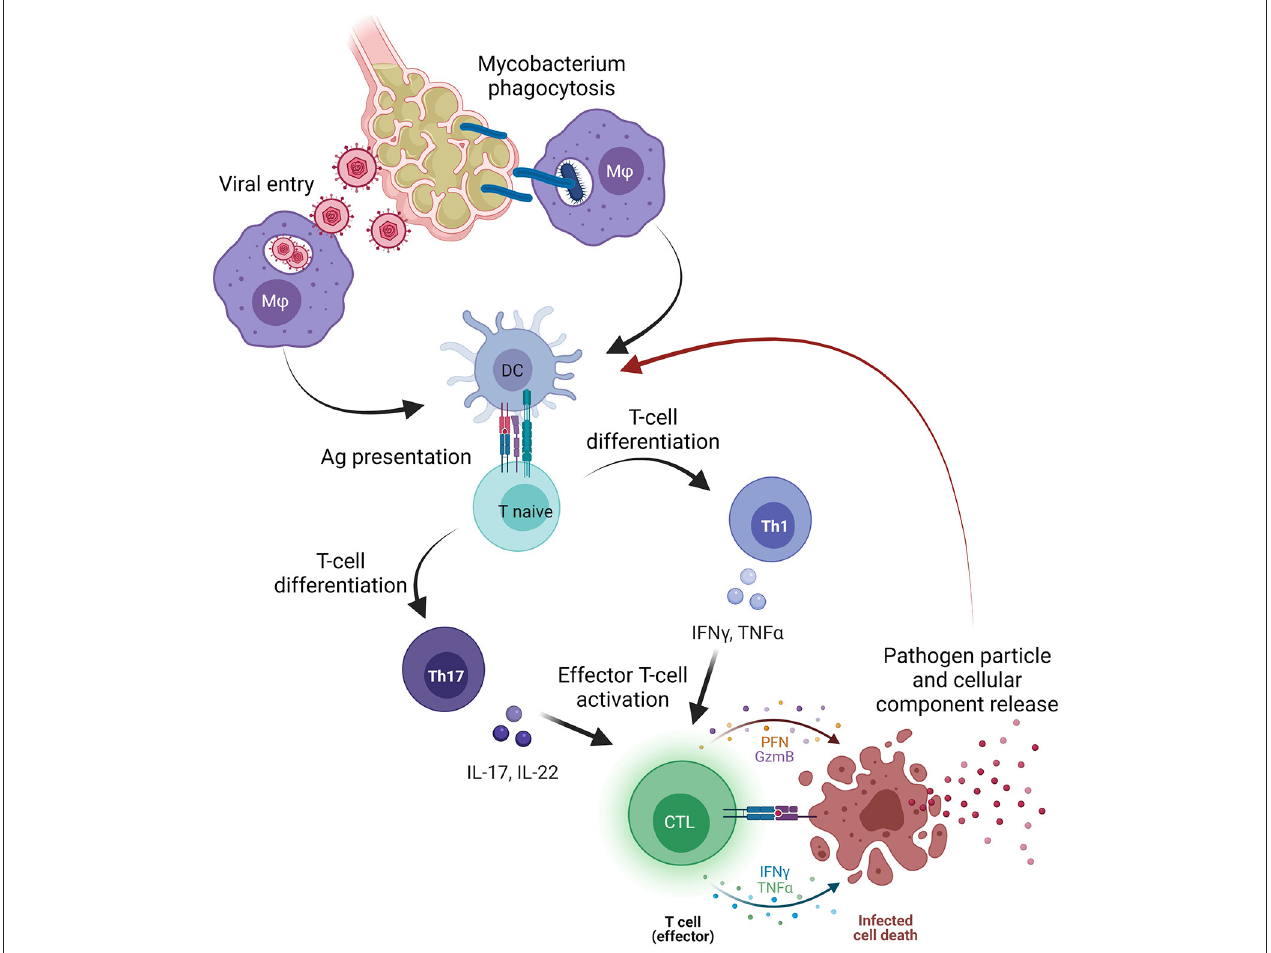
FIGURE 1 | Pathogen involvement in bone marrow failure (BMF). Primary viral or mycobacterial infection occurs in the lower pulmonary system where pathogens infect alveolar cells and macrophages (M ϕ ), or where M ϕ phagocyte mycobacteria containing the infection. Subsequently, M ϕ migrate to pulmonary lymph nodes and presents antigens (Ag) to dendritic cells that processed and present Ag to naïve T cells. Once primed, naïve T cells differentiate primarily in T helper (Th) 1 cells releasing pro-inflammatory cytokines, such as tumor necrosis factor alpha (TNF α ), interferon-gamma (IFN γ ), or interleukins (IL) that, together with type I